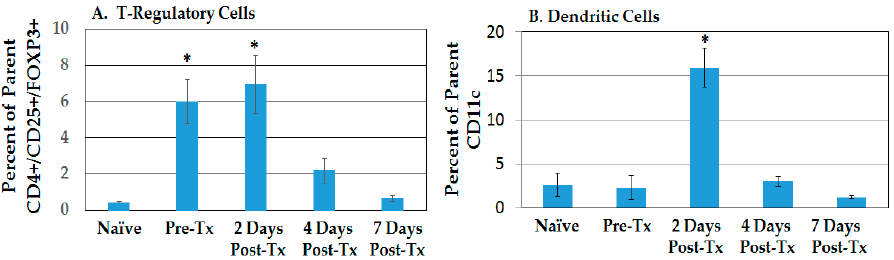
Figure 3. Immunosuppressive Tregs dissipate while dendritic cells infiltrate the TME in response to NPS. Lymphocytes were isolated from the liver of naïve rats and from rats at various times post-Tx and stained with either ( A ) FOXP3/CD25/CD4 (naïve n = 4, others n = 2) or with ( B ) CD11c (Naïve n = 5, Pre-Tx n = 4, 2 days n=4, all others n = 6); error bars = SEM. * p <